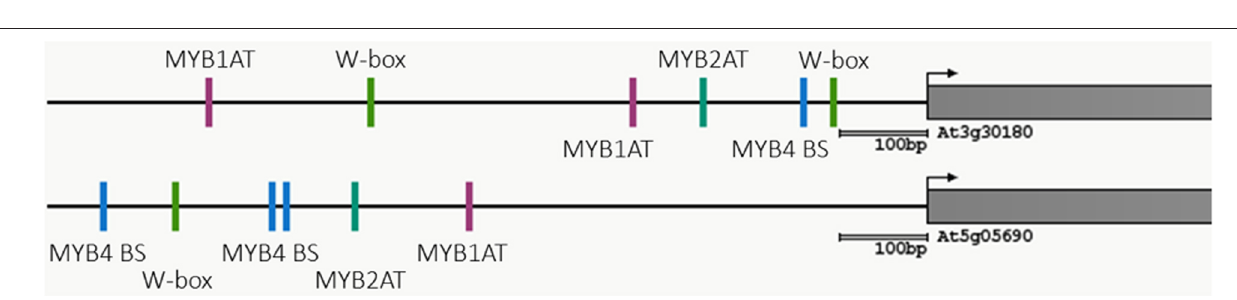
FIGURE 4 | Common transcription binding sites present in the promoters of CPD (At5g05690) and BR6ox2 (At3g30180). The figure has been modified from the Athena output